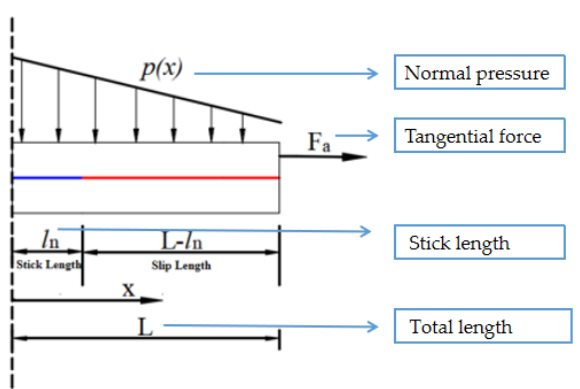
Figure 15. Dry friction model.